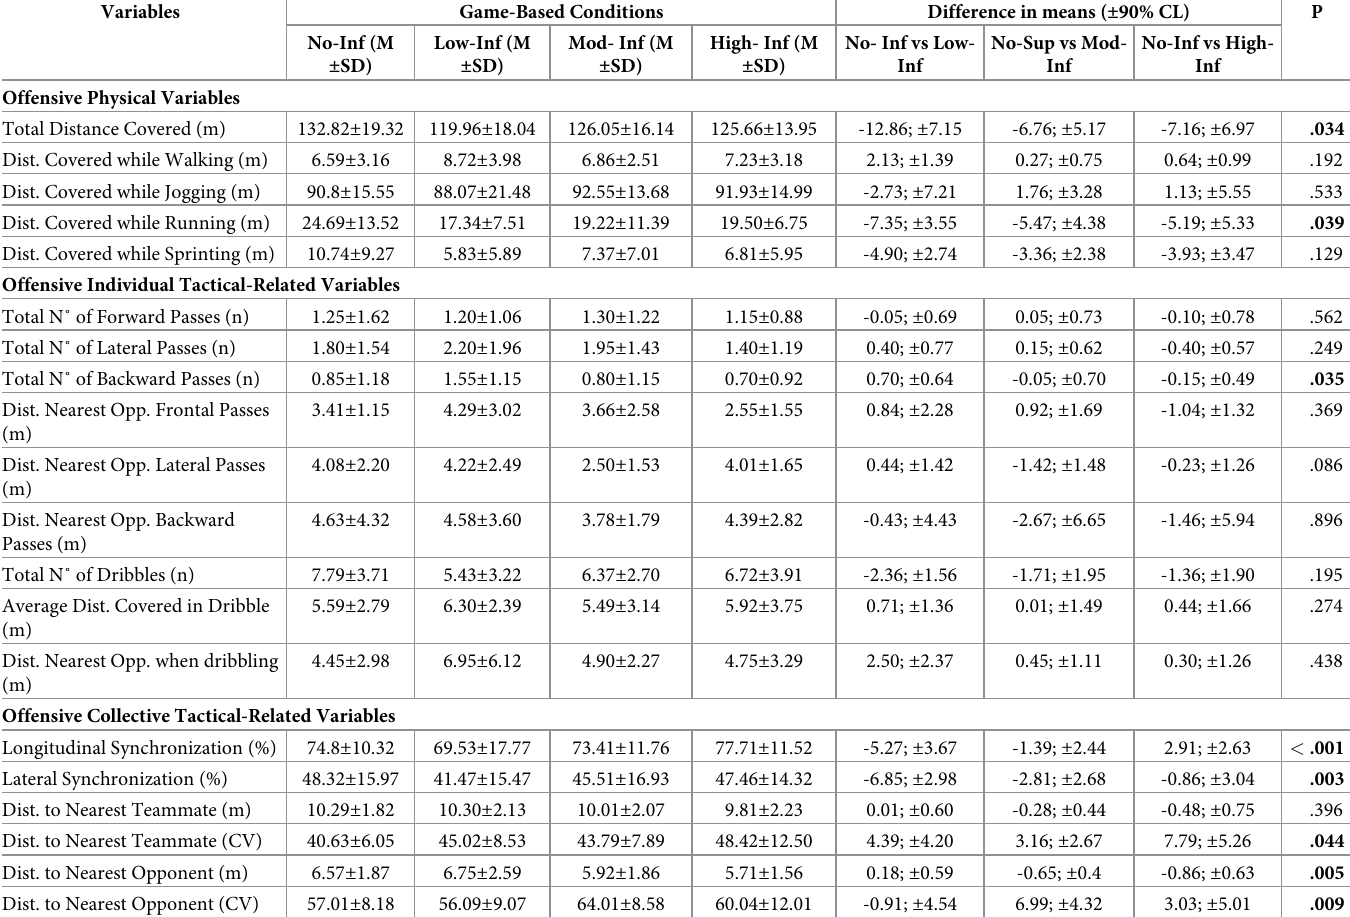
Table 3. Descriptive and statistical analysis for physical, individual and collective tactical-related variables when playing in inferiority (opposition-perspective) dur- ing the offensive phase.